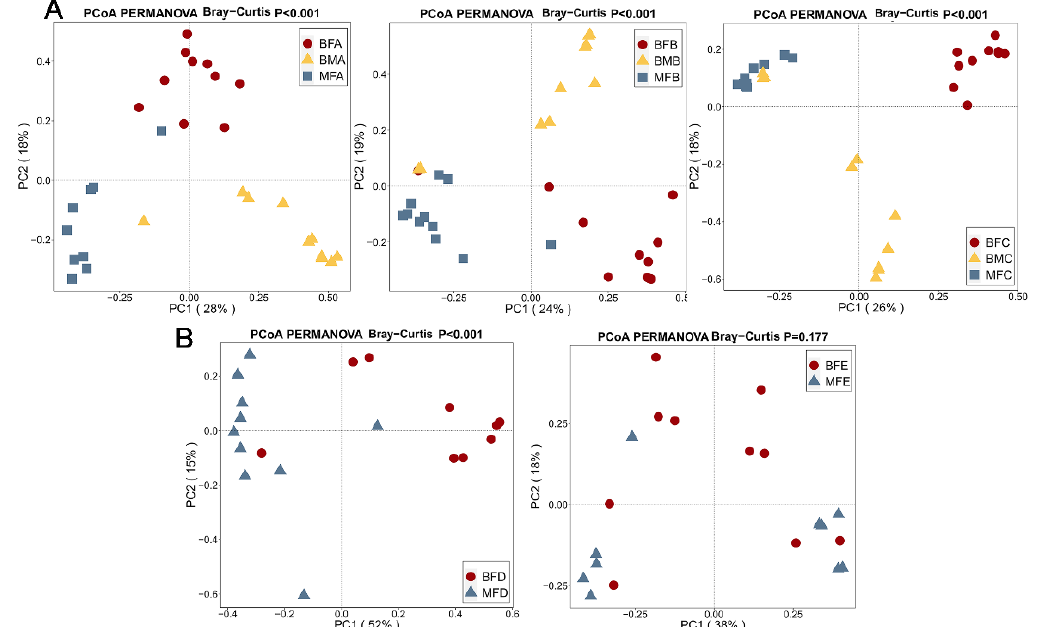
Figure 2. Beta-diversity illustrating composition in microbiota of of human breast milk, maternal and infant feces. ( A ) samples collected before six months of age. ( B ) samples collected between six and 24 months of age. PERMANOVA was used to calculate the difference among samples based on Bray–Curtis distance. p < 0.05 stands for significantly different microbiota composition was found among samples. BMA: breast milk (corresponding to infant younger than one month of age), BMB: breast milk (corresponding to infant between 1 and three months of age), BMC: breast milk (corresponding to infant between three and six months of age), MFA: maternal feces (corresponding to infant younger than one month of age), MFB: maternal feces (corresponding to infant between 1 and three months of age), MFC: maternal feces (corresponding to infant between three and six months of age), MFD: maternal feces (corresponding to infant between six and 12 months of age), MFE: maternal feces (corresponding to infant older than 12 months of age), BFA: infant feces younger than one month of age, BFB: infant feces between 1 and three months of age, BFC: infant feces between three and six months of age, BFD: infant feces between six and 12 months of age, BFE: infant feces older than 12 months of age.